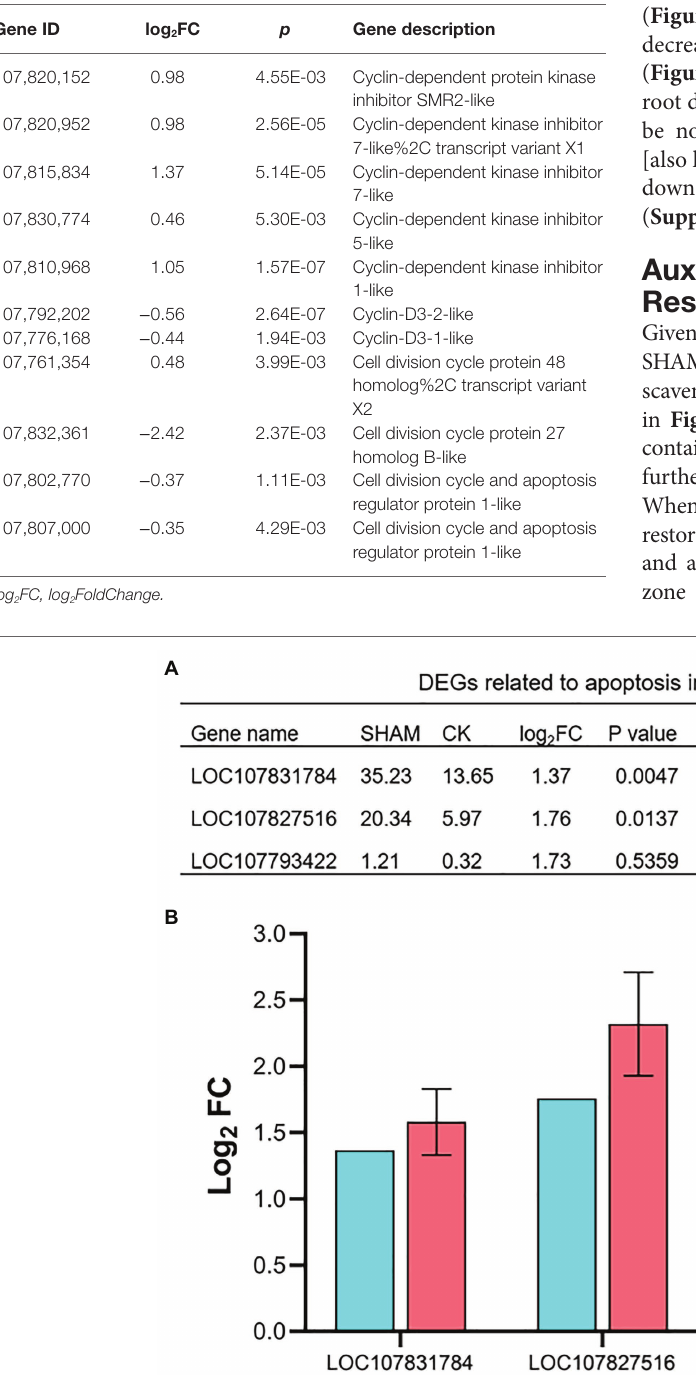
TABLE 2 | DEGs related to cell cycle.